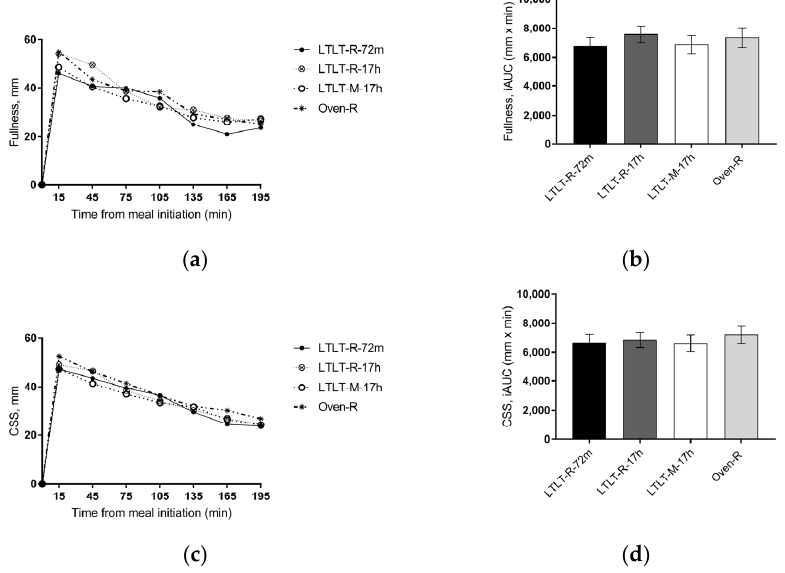
Figure 2. Fullness: ( a ) mean 3-hour response and ( b ) incremental area under the curve (iAUC). Composite satiety score (CSS): ( c ) mean 3-hour response, and ( d ) corresponding iAUC. Values are means ± SEM, n = 37. The test meals were prepared according to Table